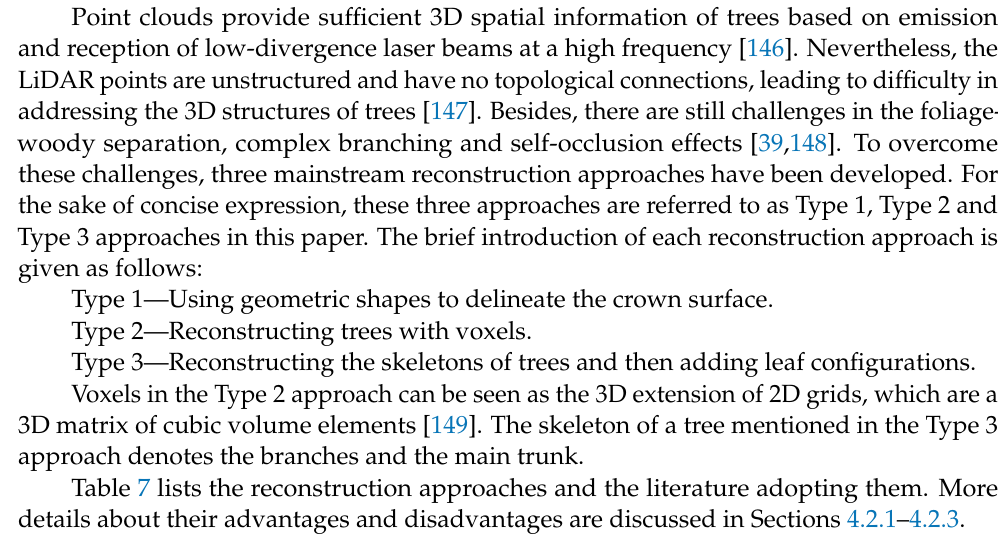
Table 7. Reconstruction approaches used for tree